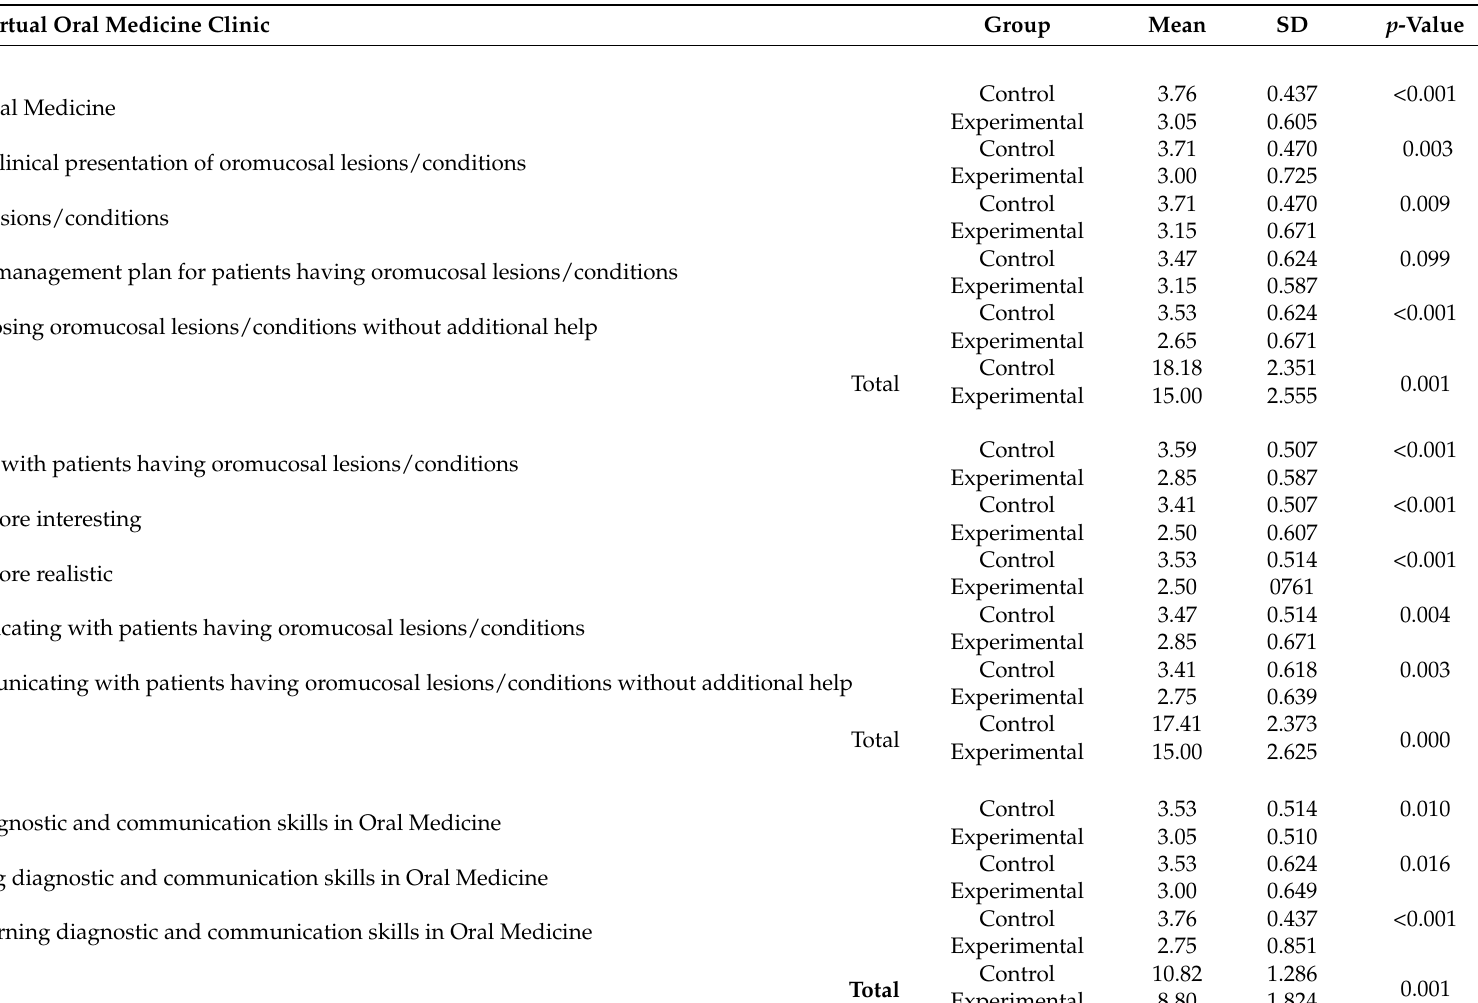
Table 5. Comparison of perceived usefulness between control and experimental